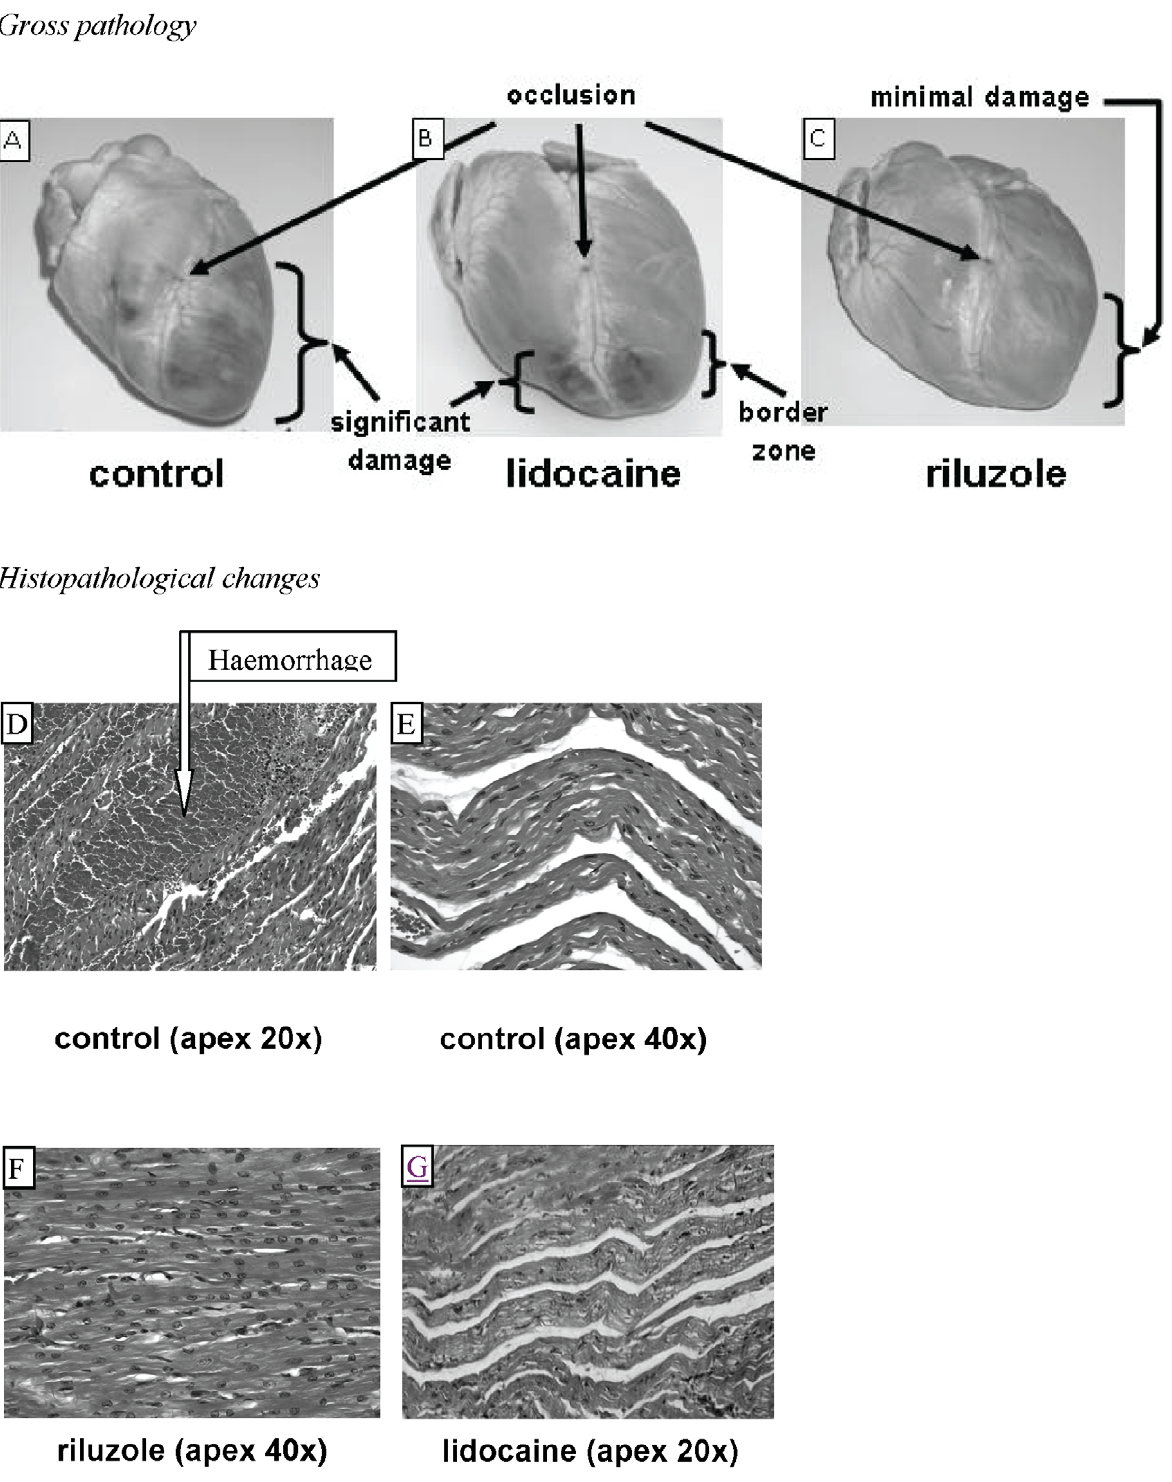
Figure 6. Pathologic changes. Upper panels: Examples of the gross pathologic damage in the control (panel A), lidocaine (panel B) and riluzole (panel C) groups. Note the shadow representative of the border zone in the lidocaine group and the minimal damage in the riluzole group. Lower panels: Examples of microscopic myocardial damage. Panel D shows haemorrhage and oedema in a control heart at low magnification. Panel E shows extensive oedema in a control heart at high magnification. Panel F shows minimal haemorrhage or oedema in a riluzole heart at high magnification. Panel G shows moderate oedema in a lidocaine heart at low magnification.